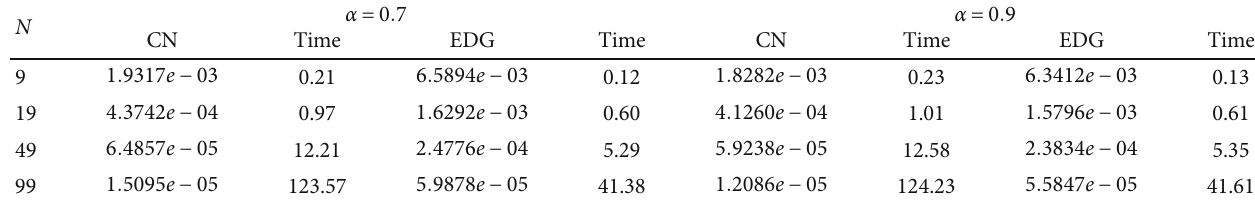
Table 6: Absolute errors of Example 15 at T = 1 for Re = 5 , Δ t = 0 : 01 , α = 0 : 7 , and α = 0 : 9